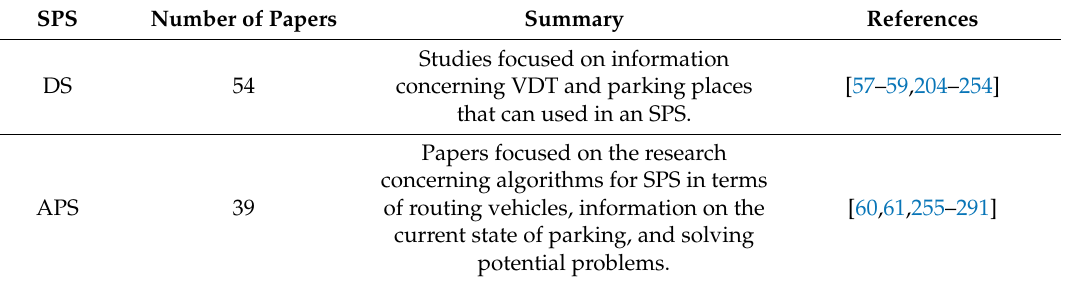
Table 7. Number of publications for unclassified work, along with a summary and references. SPS